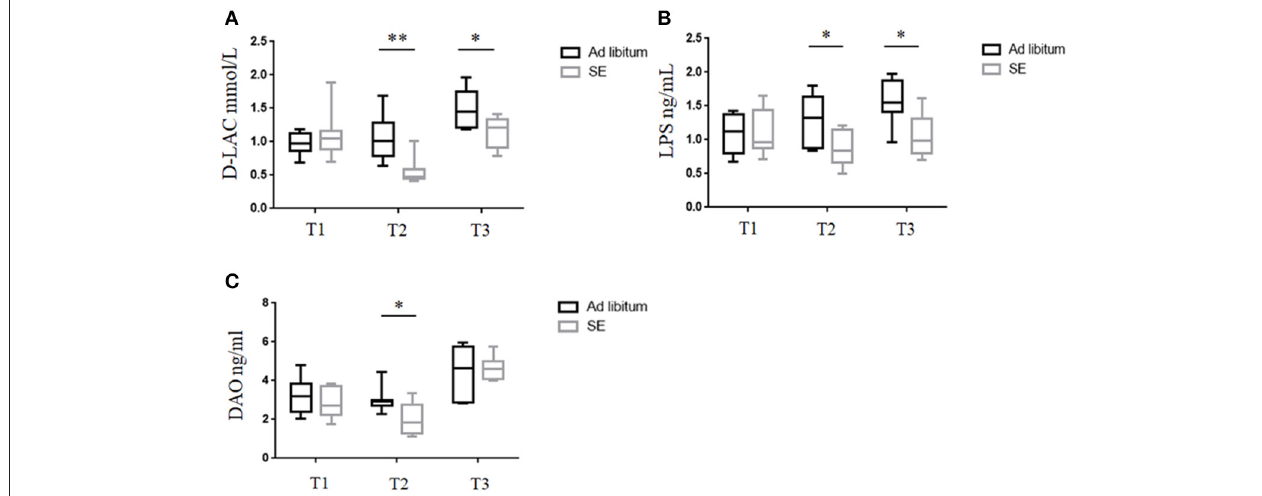
FIGURE 3 | Strength exercise was associated with decreased intestinal permeability damage markers. ( n = 10) (A–C) Serum levels of (A) D-lactate (D-lac), (B) lipopolysaccharide (LPS), and (C) diamine oxidase (DAO) were measured by ELISA at different time points during the experiment. In the ELISA, each sample was run in duplicate. Measurements for D-lac, LPS, and DAO were performed in three independent experiments with similar results. * p < 0.05, ** p < 0.01. All p -values were calculated by Mann–Whitney